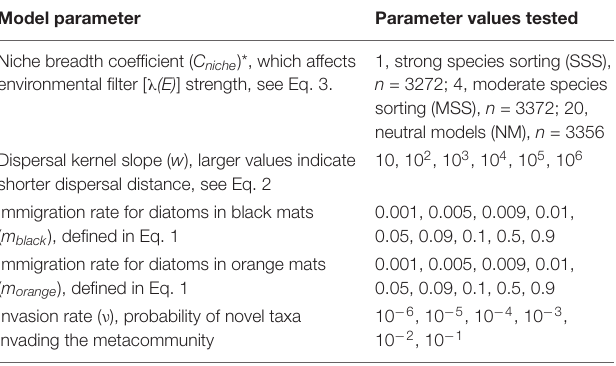
TABLE 4 | Model parameters used in metacommunity simulations. Model parameter Parameter values